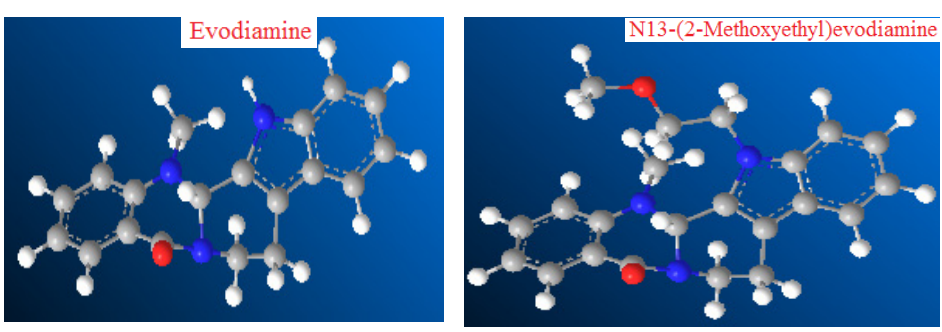
Figure 2. Three-dimensional models of evodiamine, N13-(2-methoxyethyl)evodiamine and N13-(2-butoxyethyl)evodiamine and